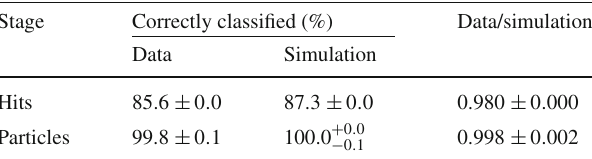
Fig. 9 The CNN shower classifier scores for cosmic-ray muon hits from experimental data (black) and simulation (red). The error bars on the data are statistical Table 1 The fraction of correctly classified cosmic-ray muon hits and particlesusingtheCNNmeasuredforexperimentaldataandsimulation. The errors represent the statistical uncertainties calculated using the Clopper–Pearson method